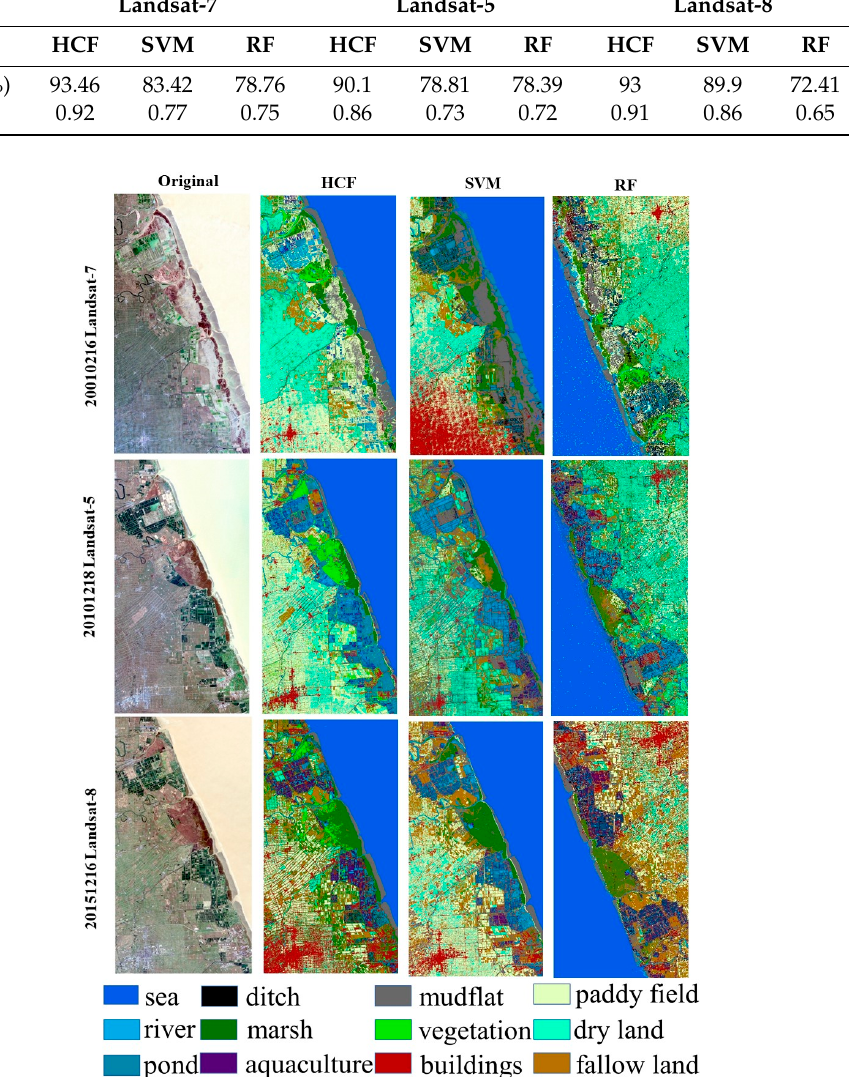
Figure 6. Classification Maps of HCF, SVM and RF on Yancheng coastal wetland Landsat data.